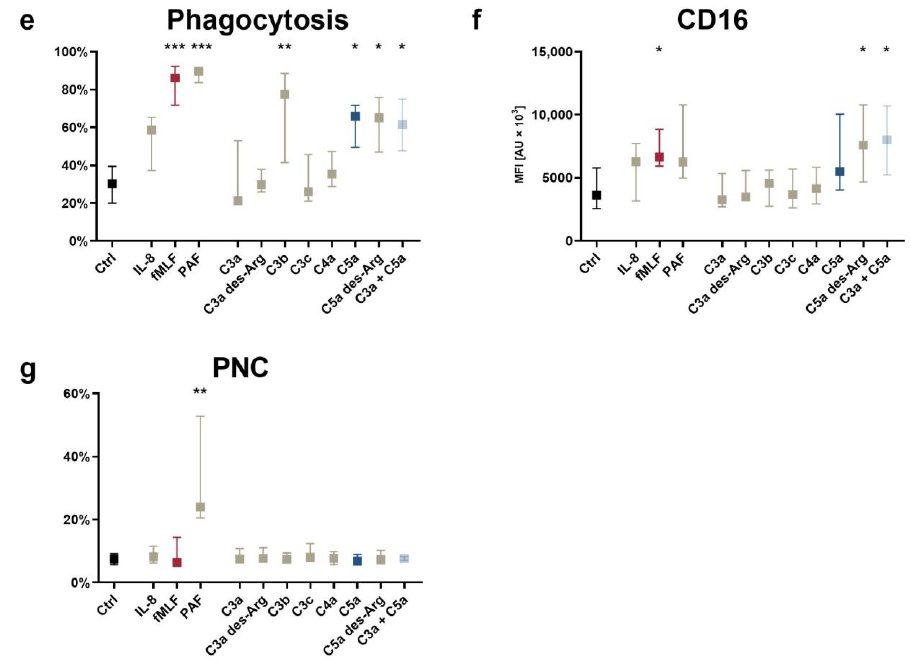
Figure 2. Changes in neutrophil activation markers and cellular functions after exposure to comple- ment cleavage products with respect to ( a ) CD10, ( b ) CD15, ( c ) CD62L, ( d ) the generation of ROS, ( e ) phagocytotic activity, ( f ) CD16, and ( g ) the formation of platelet–neutrophil complexes (PNCs). Y-axis reports the median fluorescence intensity (MFI) for all CD molecules, the percent positive for PNC formation and phagocytosis, and the increase in ROS production normalized to unstimulated neutrophils (= 0). The following concentrations were used: 10 nM C5a, 10 nM C5a des-Arg, 10 µ M fMLF, 50 ng/mL IL-8, 100 nM C3a, 100 nM C3a des-Arg, 100 nM C3b, 100 nM C3c, or 100 nM C4a. n = 6–8, median ± interquartile range. *, **, and *** = p < 0.05, < 0.01, and < 0.001, respectively. Kruskal–Wallis test with uncorrected Dunn’s test.